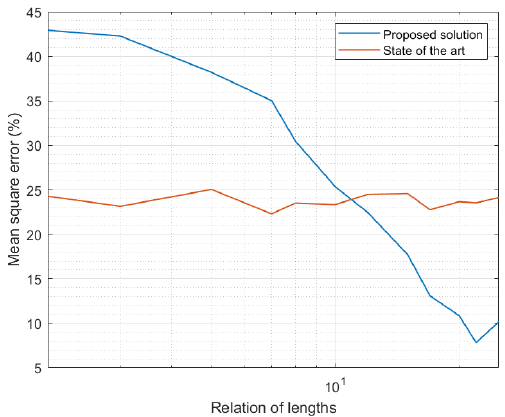
Figure 6. Results of the third experiment: comparison with state-of-the-art solutions [56].